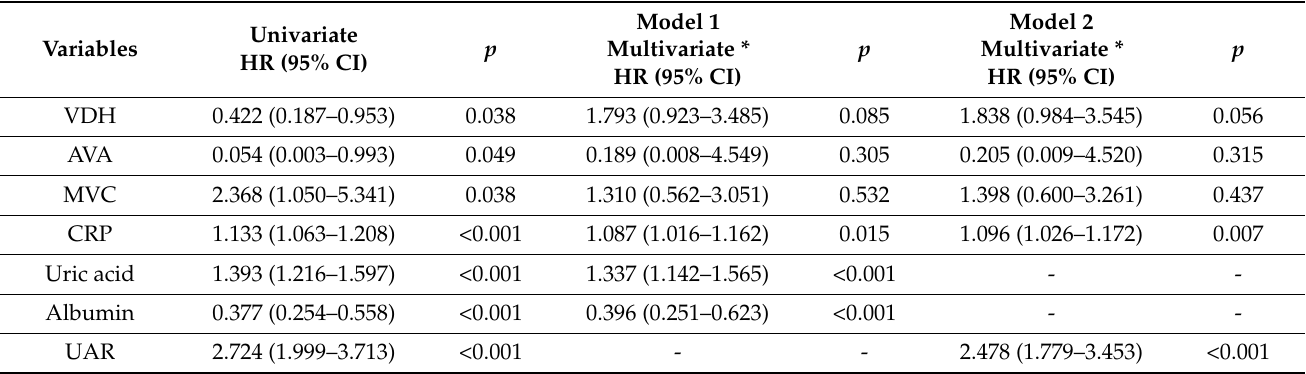
Table 3. Factors that were found to be independently associated with the MACCEs in univariate and multivariate regression analysis models.